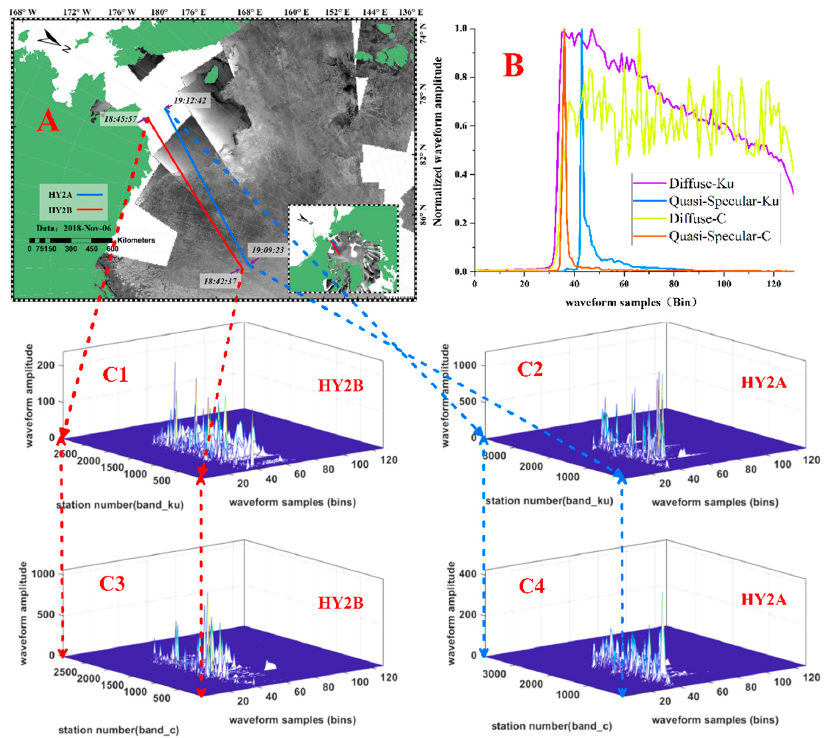
Figure 4. Typical waveforms and distribution of the waveforms: ( A ) Distribution maps of the data, in which the mosaic product of the Sentinel-1a / b (3-day) of the base map shows clear distinctions between the sea ice and seawater; ( B ) normalized typical waveforms (C1 to C4), in which the original waveforms of the di ff erent bands along the orbit are